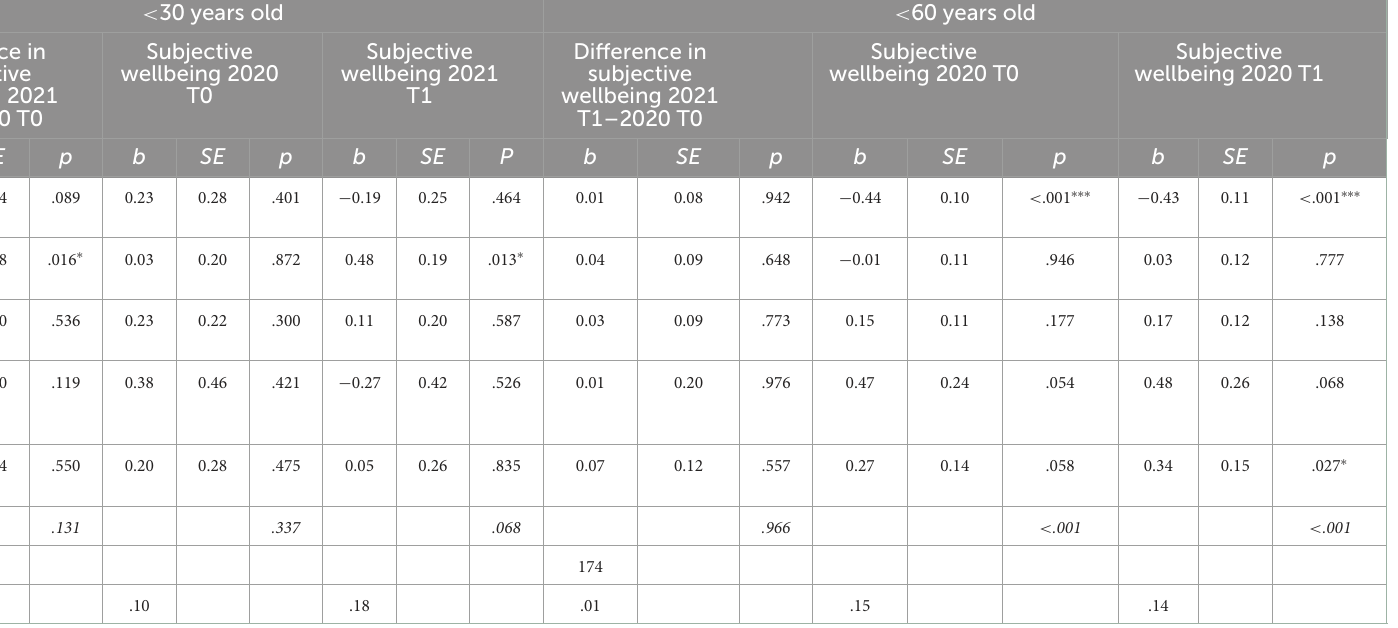
TABLE 3 Multiple moderator analysis predicting subjective wellbeing.